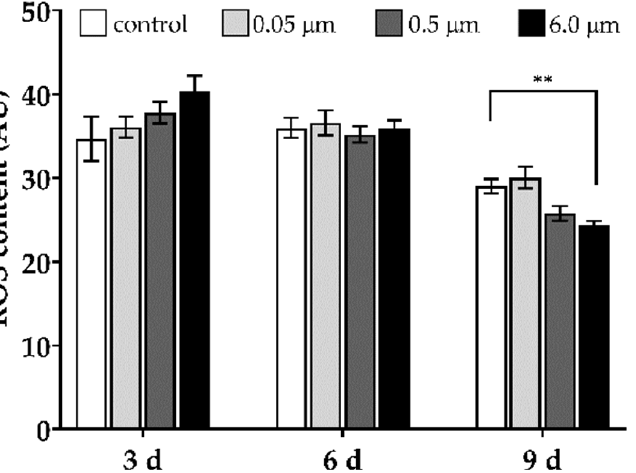
Figure 4. ROS contents of embryos exposed to PS-MPs of different sizes for 3, 6, and 9 dpf (n = 9). Asterisk indicates significant difference between the treatment group and the control (** p < 0.01).